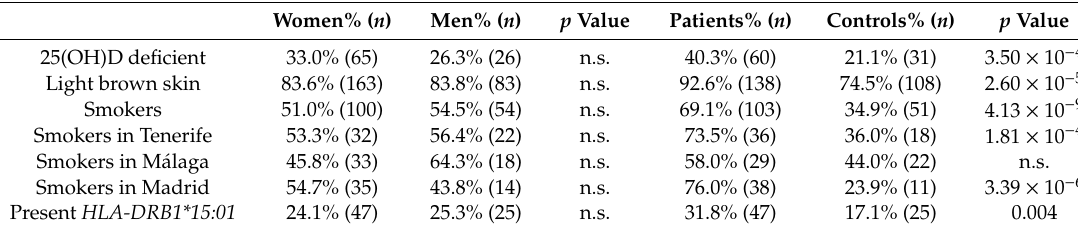
Table 1. Relative (%) and absolute ( n ) frequency of study